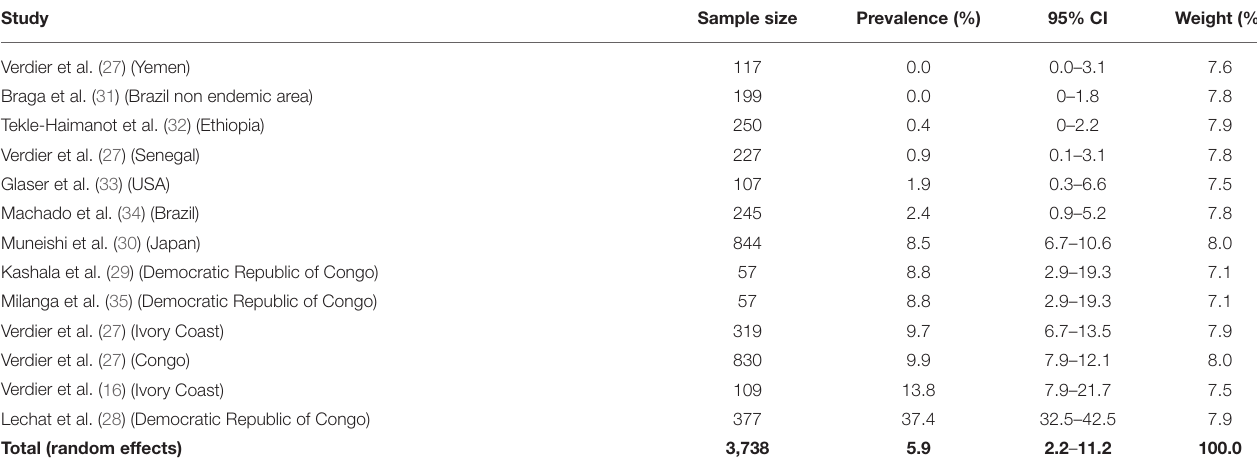
TABLE 2 | Prevalence of HTLV-1 infection in patients with M. leprae .